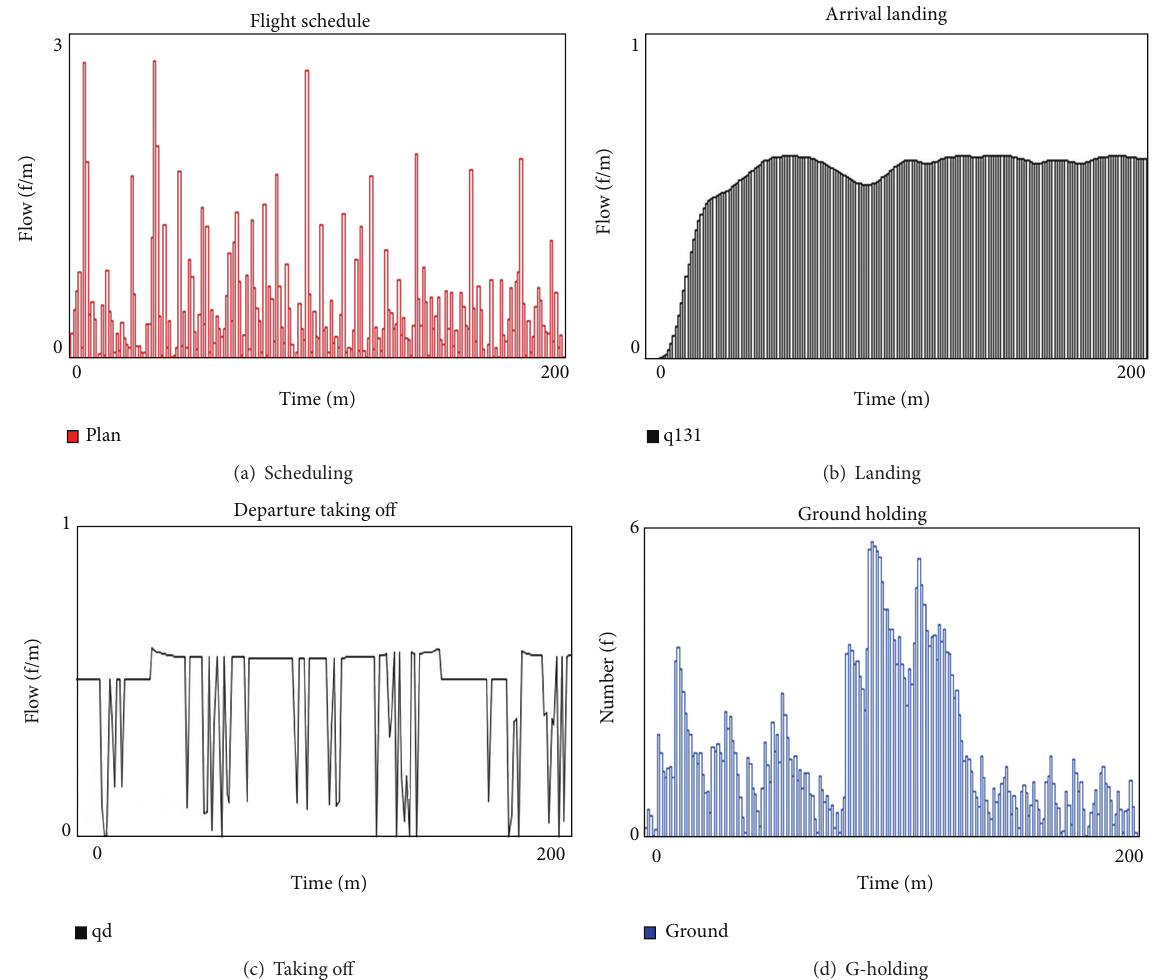
Figure 8: Changes of traffic flux and stock over time in airport surface part